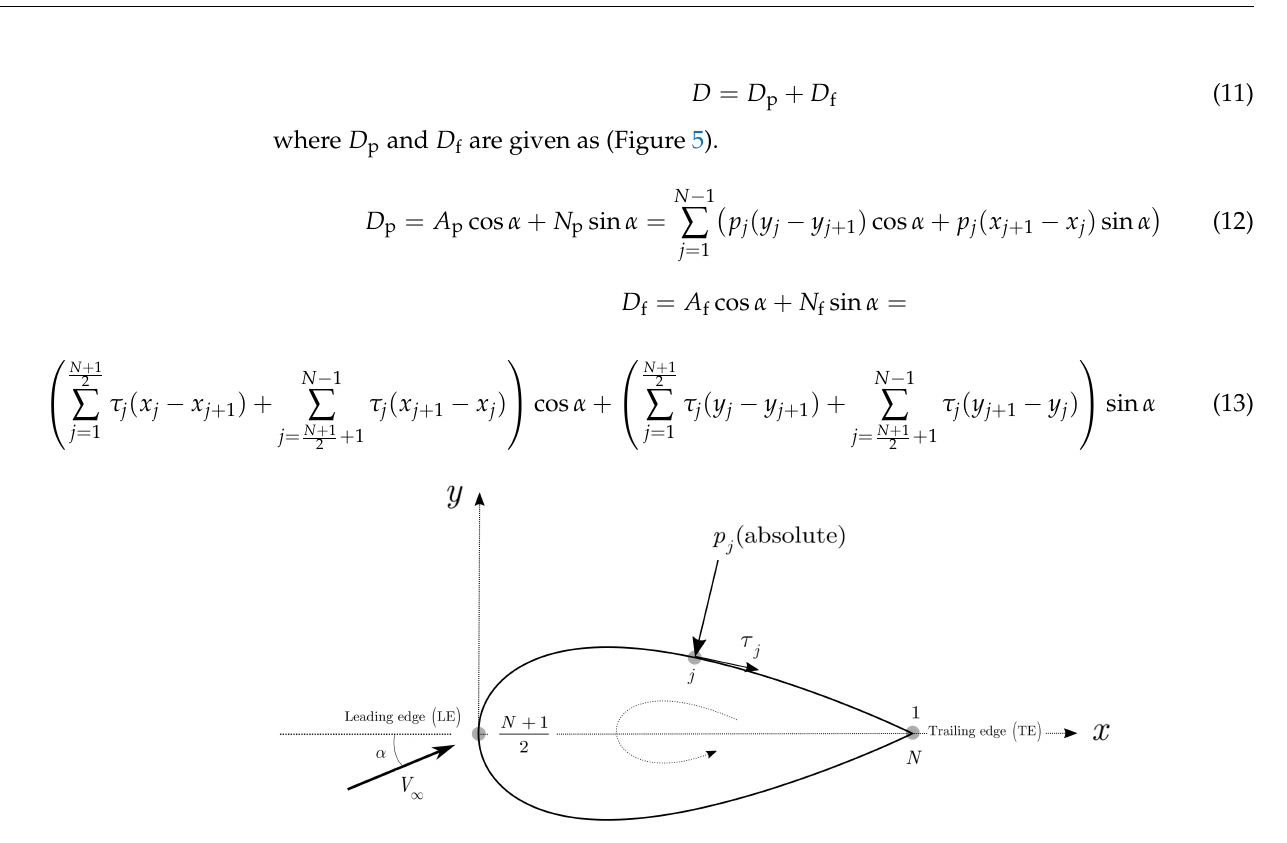
Figure 5. Pressure and shear stress applied on an airfoil